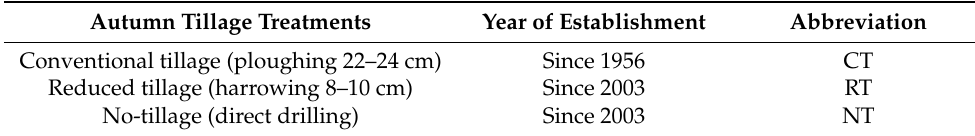
Table 4. Experimental design. Autumn Tillage Treatments Year of Establishment